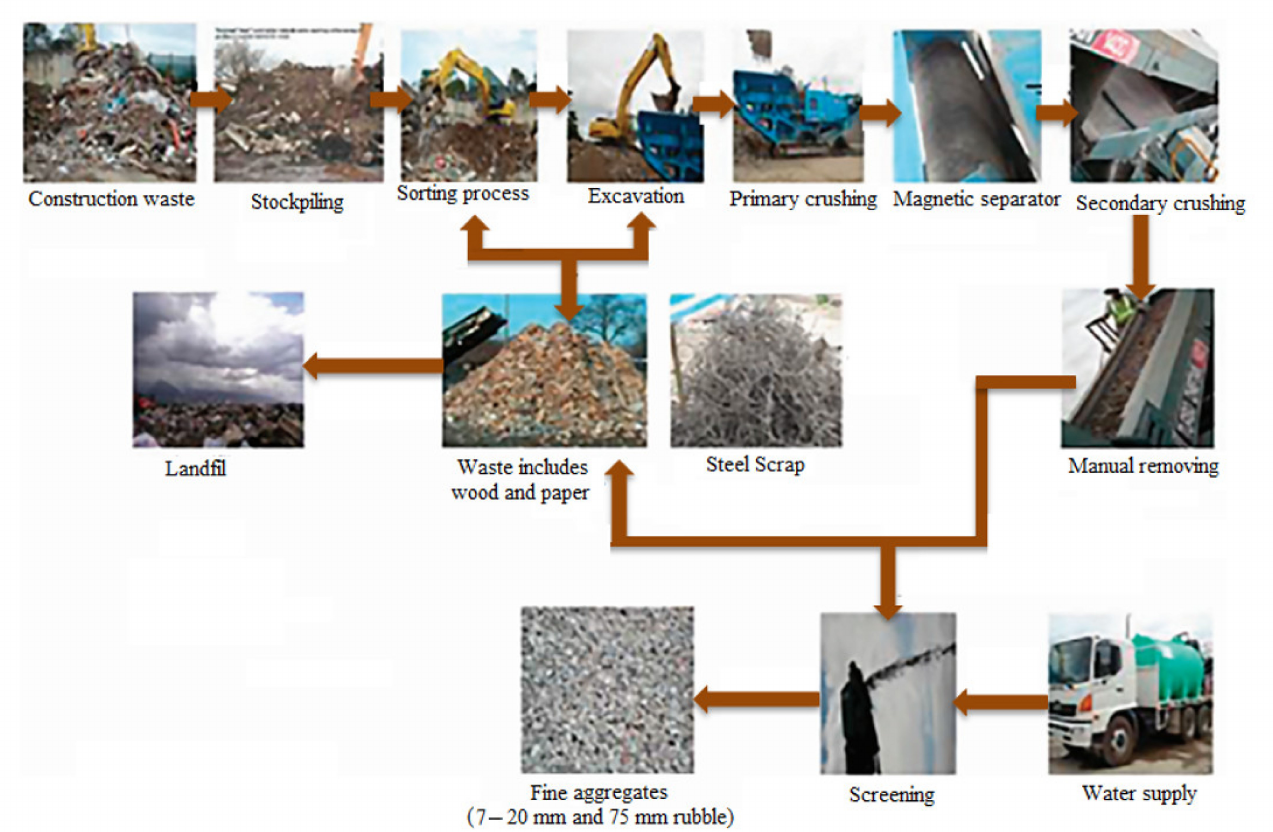
Figure 5. Current recycling process of